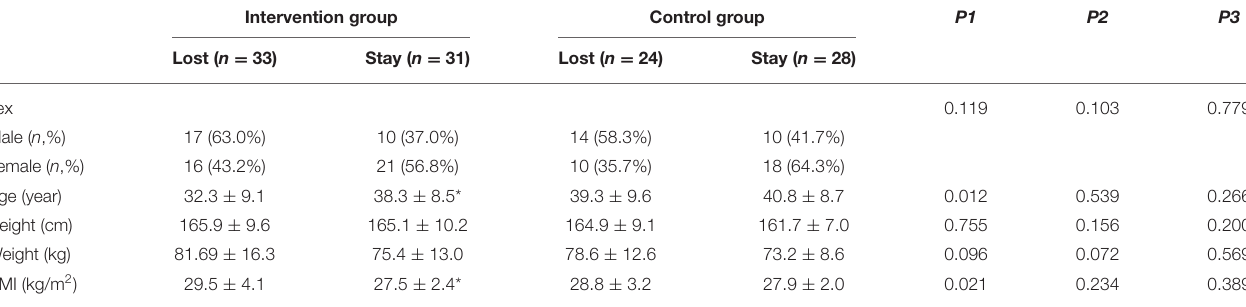
TABLE 2 | Characteristics of